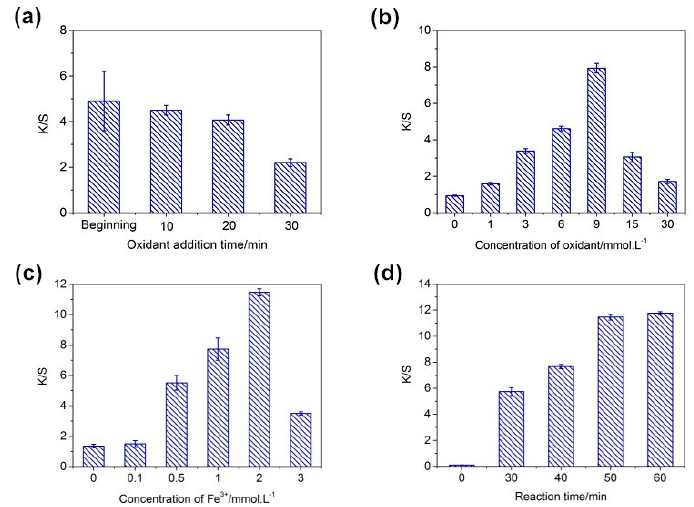
Figure 3. The effect of time of Ox addition ( a ), Ox concentration ( b ), Fe 3+ concentration ( c ), and reaction time ( d ) on the K / S values of silk fabric. (( a ) DA = 2 g·L − 1 , Fe 3+ = 1 mmol·L − 1 , Ox = 15 mmol·L − 1 , T = 50 °C, t = 40 min; ( b ) DA = 2 g·L − 1 , Fe 3+ = 1 mmol·L − 1 , T = 50 °C, t = 40 min (adding Ox at 20 min); ( c ) DA = 2 g·L − 1 , Ox = 9 mmol·L − 1 , T = 50 °C, t = 40 min (adding Ox at 20 min); ( d ) DA = 2 g·L − 1 , Fe 3+ = 2 mmol·L − 1 , Ox = 9 mmol·L − 1 , T = 50 °C (adding Ox at 20 min)).